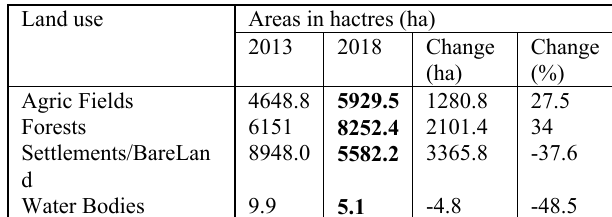
Table 4. Land cover change